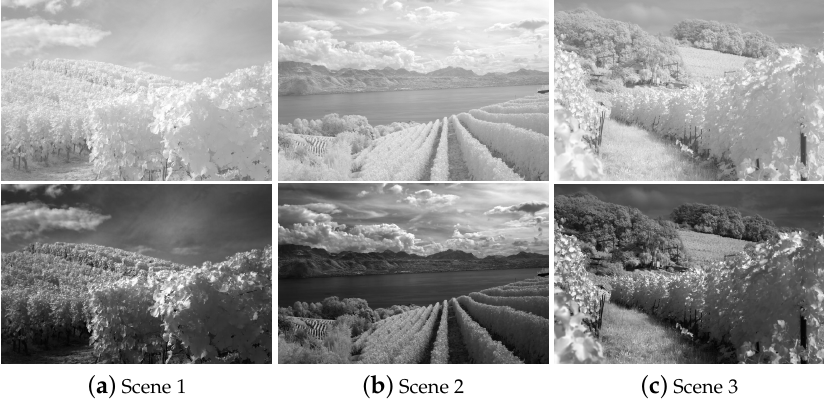
Figure 3. IR images and the effects of γ on the base layer of the stretched IR